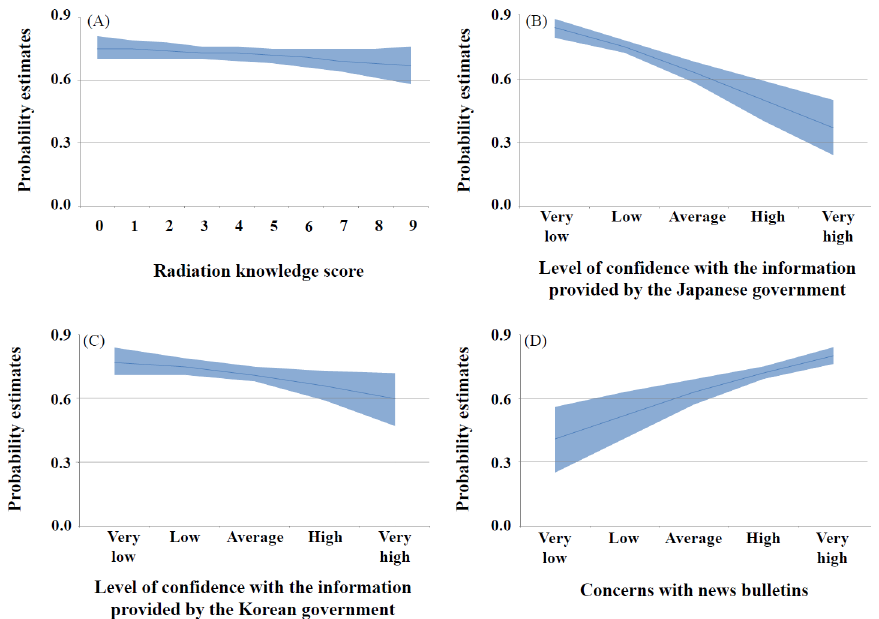
Fig 2. Changes in the purchase intentions of Japanese seafood with non-detectable levels of radiation per the radiation knowledge score, the level of confidence in the information provided by the Japanese and Korean governments, and concerns with news bulletins. The x-axis shows the radiationknowledgescore (A), level of confidencein the information providedby the Japanesegovernment (B), level of confidencein the informationprovidedby the Korean government (C), and the concernswith news bulletins(D). The y-axis denotesprobabilityestimates of non-intention to purchaseJapaneseseafood with non-detectable levels of radiation after adjustingfor significantvariablesin the multivariate model. The 95% confidenceintervalon the estimates is shown in blue shading. The increase in radiationknowledge score, as well as the levels of confidencein the information by Korean and Japanesegovernments decreased the probabilityof non-purchasing intentionsof Japaneseseafoodwith non-detectable levels of radiation(A, B, C). The increasedconcernswith news bulletins were associated with an increasedprobabilityof non- purchasing intentions(D).